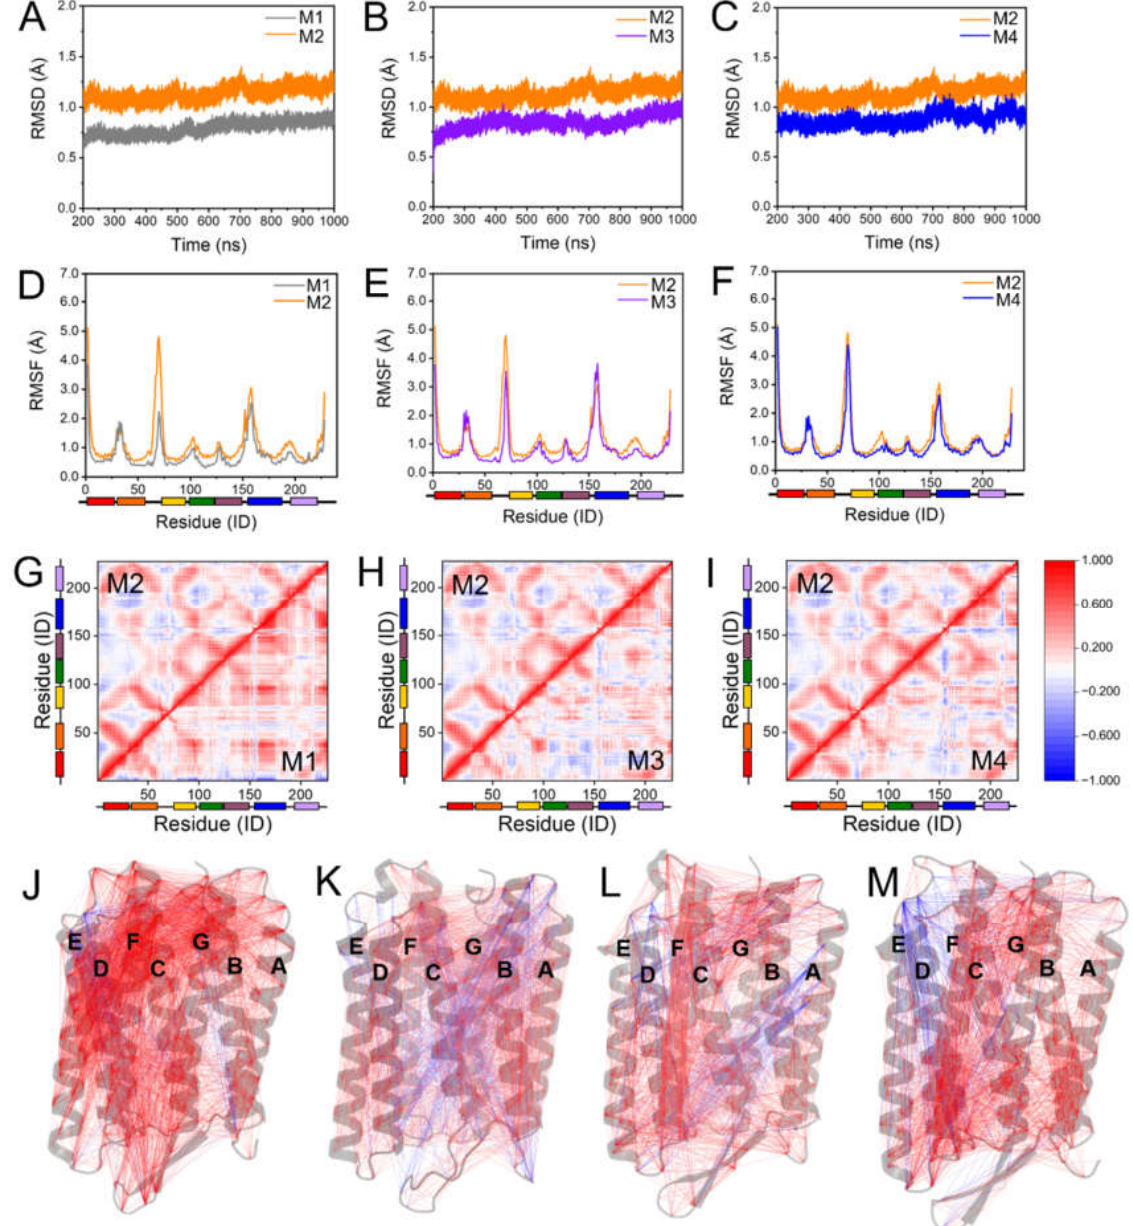
Figure 2. The influence of S-TGA-1 and PGP-Me on the dynamic stability of the bR trimer. ( A – C ) Time evolutions of the root mean square deviation (RMSD) of the Cα atoms during the simulations. ( A ) M1 (bR trimer with POPC, S-TGA-1, and PGP-Me, grey line) vs. M2 (bR trimer with POPC only, orange line); ( B ) M3 (bR trimer with POPC and S-TGA-1, purple line) vs. M2; ( C ) M4 (bR trimer with POPC and PGP-Me, blue line) vs. M2; ( D – F ) time evolutions of root mean square fluctuations (RMSF) of the Cα atoms: ( D ) M1 vs. M2; ( E ) M3 vs. M2; ( F ) M4 vs. M2; ( G–I ) dynamic cross-correlated map (DCCM) analyses of the Cα atoms; ( G ) M1 vs. M2; ( H ) M3 vs. M2; ( I ) M4 vs. M2. The upper left triangle represents M1. The color scale represents the correlation intensity from the maximum negative value (−1) to the ultimate positive value (+1); ( J – M ) dynamic cross-correlation network (DCCN) analyses of residue–residue cross-correlations from M1 to M4. The grey cartoon represents the bR structure of Monomer1 (one of the three monomers in the bR trimer), and blue and red lines indicate the negatively and positively correlated motions, respectively.